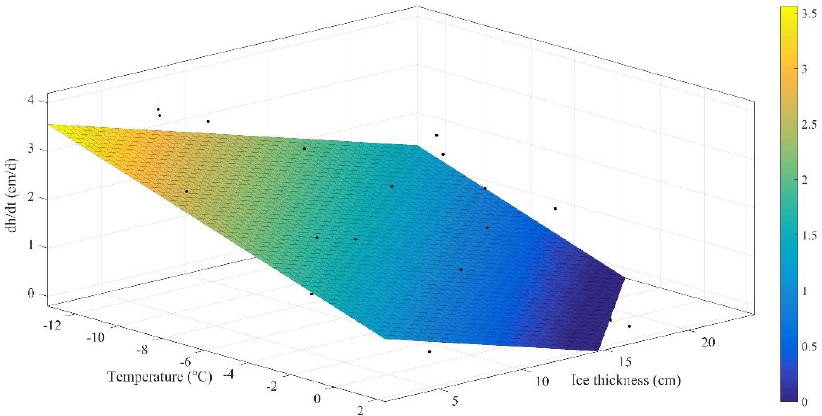
Figure 5. Statistical relationship between growth rate, ice thickness, and average daily temperature.